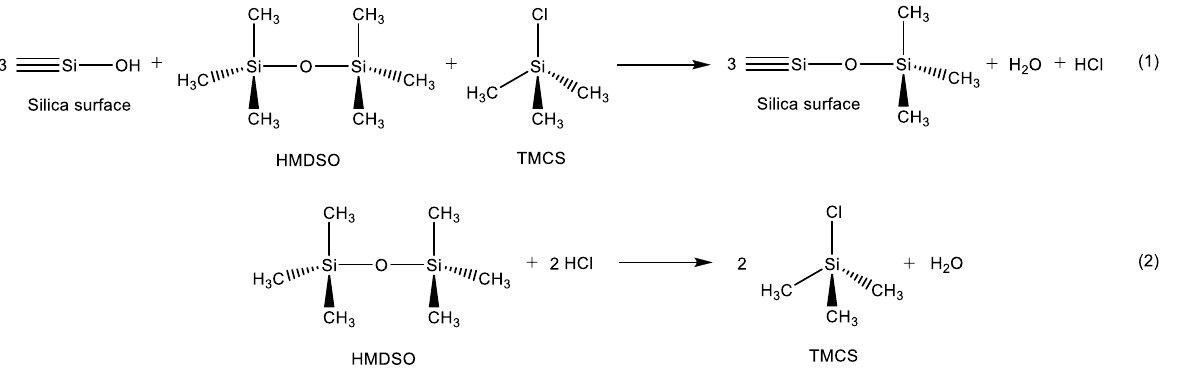
Scheme 1. Reactions of HMDSO and TMCS with silica surface (1) and reaction of HMDSO with HCl forming TMCS